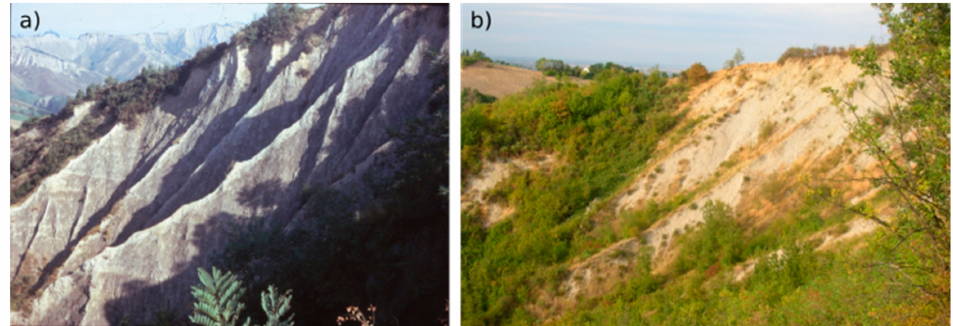
Figure 14. Vegetation change occurred in badland n. 26 between the late 1980s ( a ) and 2006 ( b ) (pho- tos: ( a ) M. Panizza; ( b ) M.